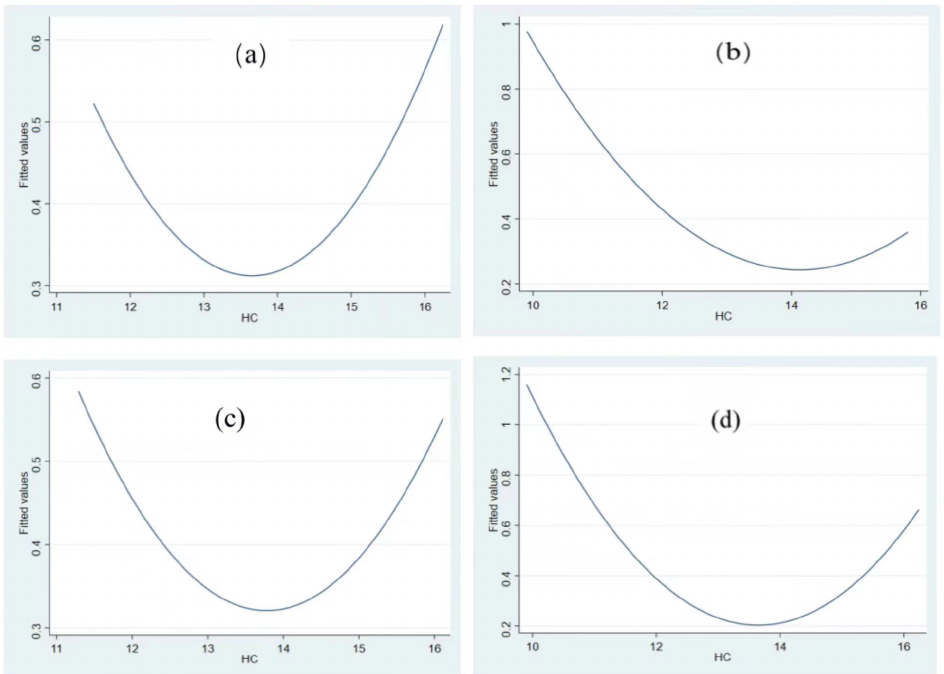
Figure 5. Fitting diagram of city’s HC and GEE in different locations. Note: ( a ) fitting diagram of HC and GEE for eastern cities; ( b ) fitting diagram of HC and GEE for western cities; ( c ) fitting diagram of HC and GEE for southern cities; ( d ) fitting diagram of HC and GEE for northern cities.